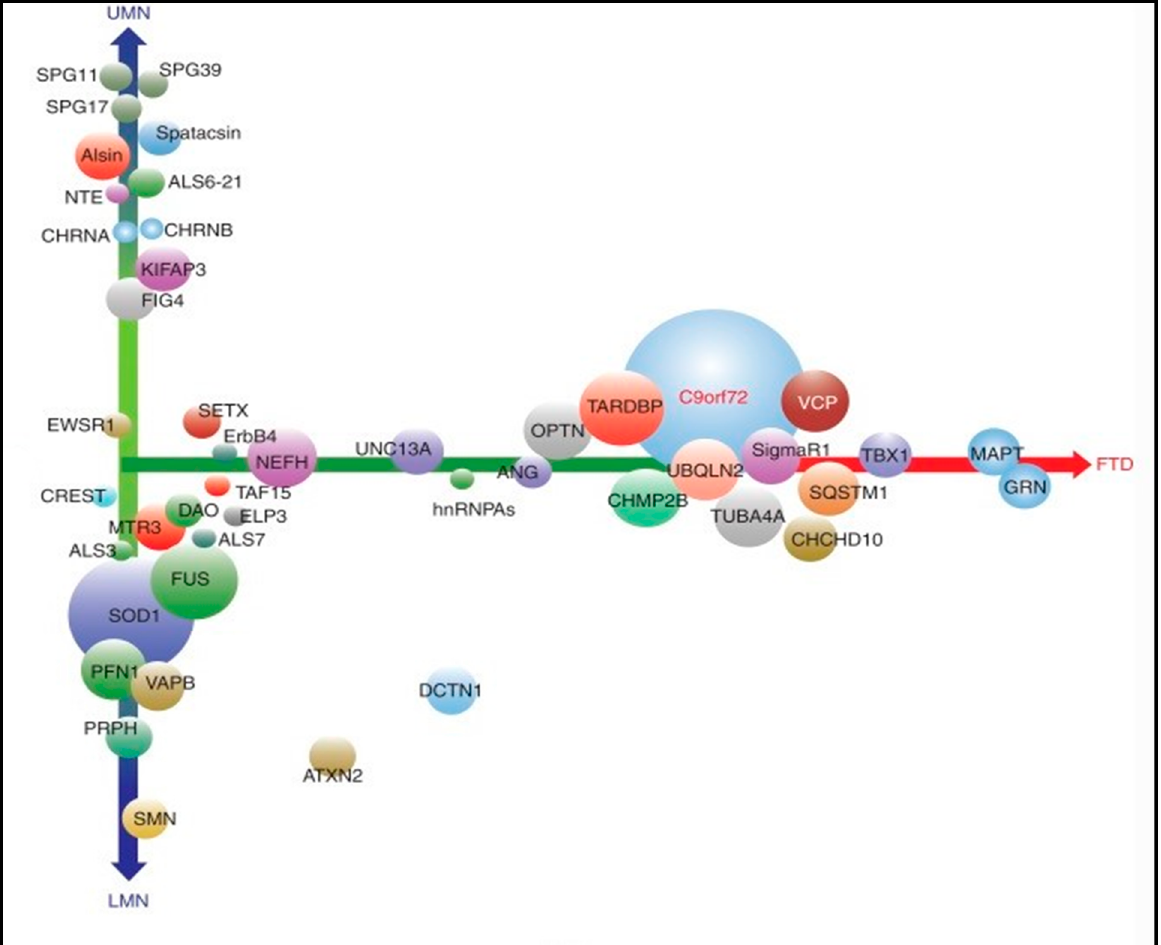
Figure 3. ALS-related genes. Symbols: LMN: Lower motor neuropathies, FTD: Frontotemporal dementia, UMN: Upper motor neurons. X -axis: Overlap with frontotemporal dementia, Y -axis: The extent to which corticospinal versus lower motor neurons are involved (updated following Ghasemi M. 2018).